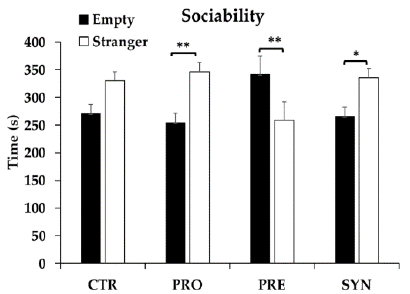
Figure 2. Sociability behavior of BTBR mice at postnatal day 43–44 following consumption of a con- trol, probiotic, prebiotic, or synbiotic diet for three weeks. Values or mean ± SEM, n = 9–10/group. * p ≤ 0.05; ** p < 0.025; CTR, control; PRO, probiotic; PRE, prebiotic; SYN, synbiotic.